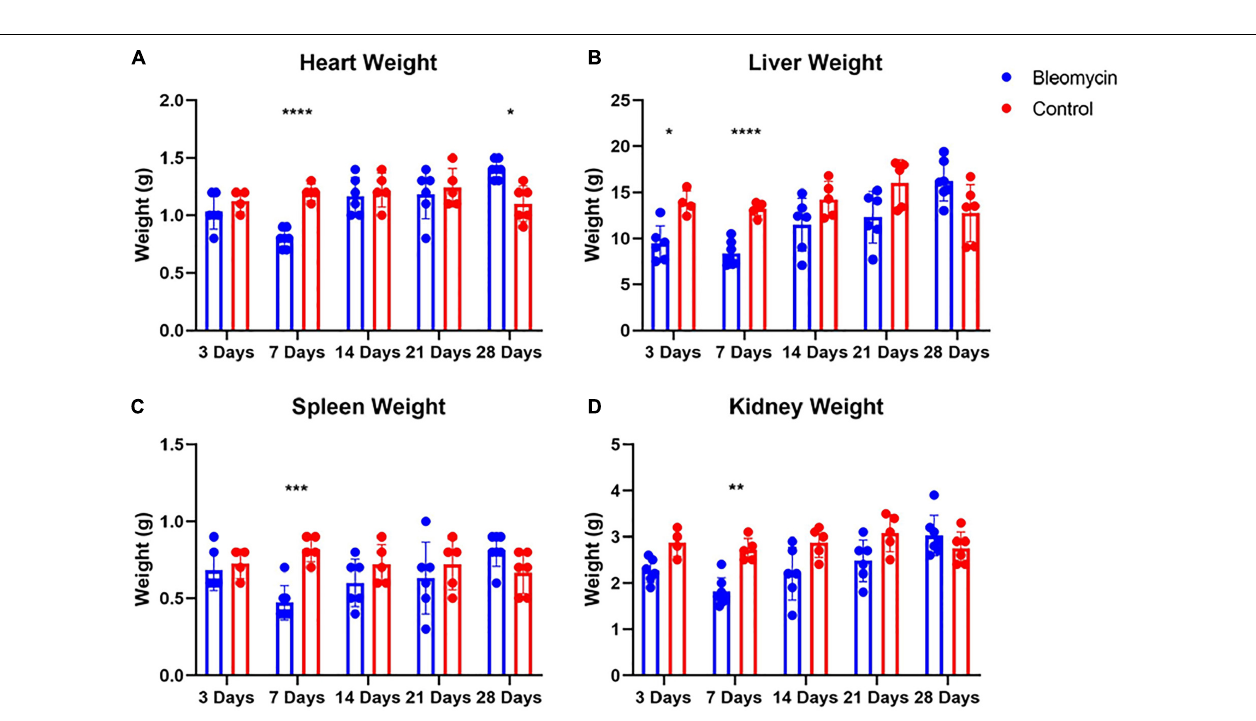
FIGURE 4 | Bleo reduced organ weights at 7-days (A–D) . Liver weight was reduced at day 3 (B) . Heart weight was increased 28 days after Bleo (A) . Mean ± SD. n = 5–7 per group. Comparing Bleo with control group * P < 0.05, ** P < 0.005, *** P < 0.0005, **** P < 0.0001.